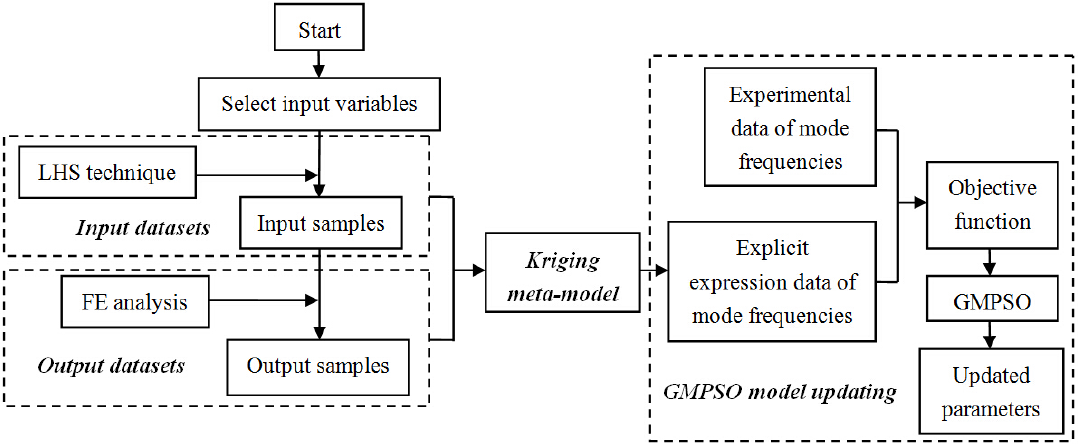
Figure 2. Flowchart of proposed hybrid method for model updating.